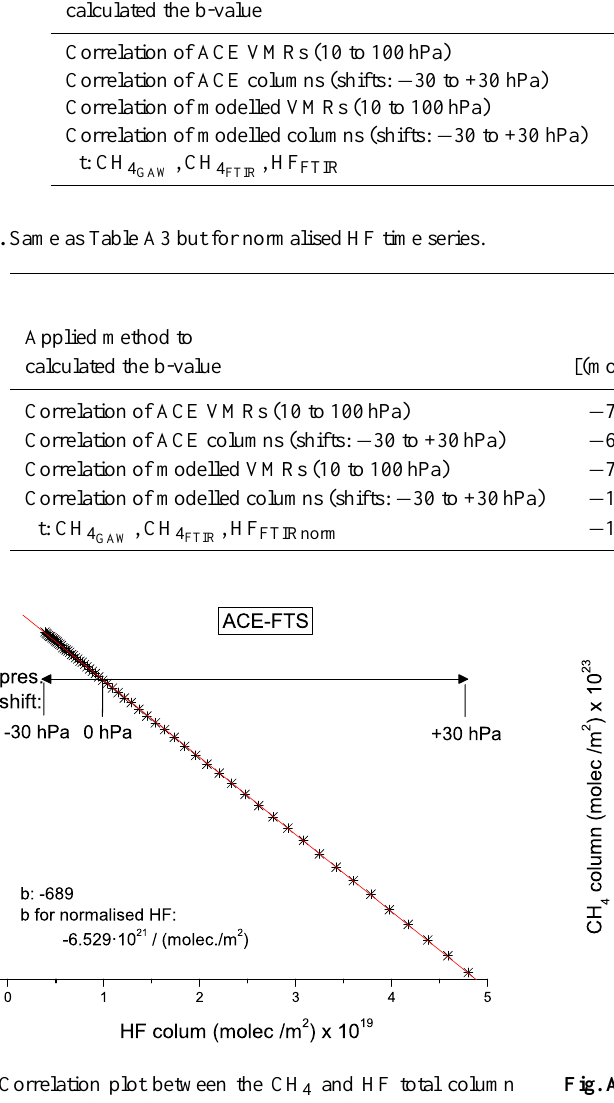
troXCH 4 vs. CH 4 post GAW